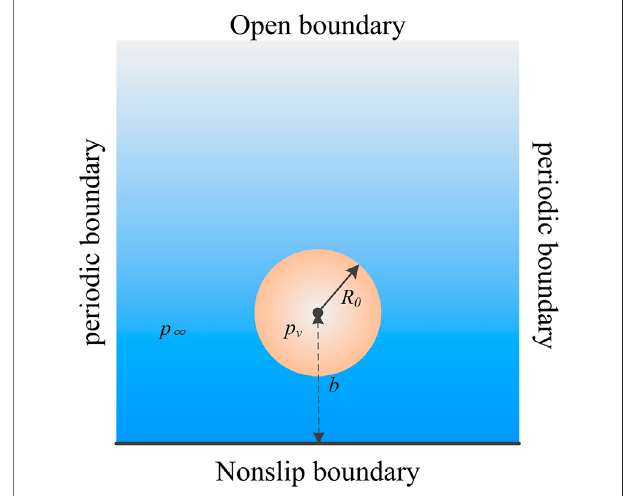
FIGURE 4 | Computational